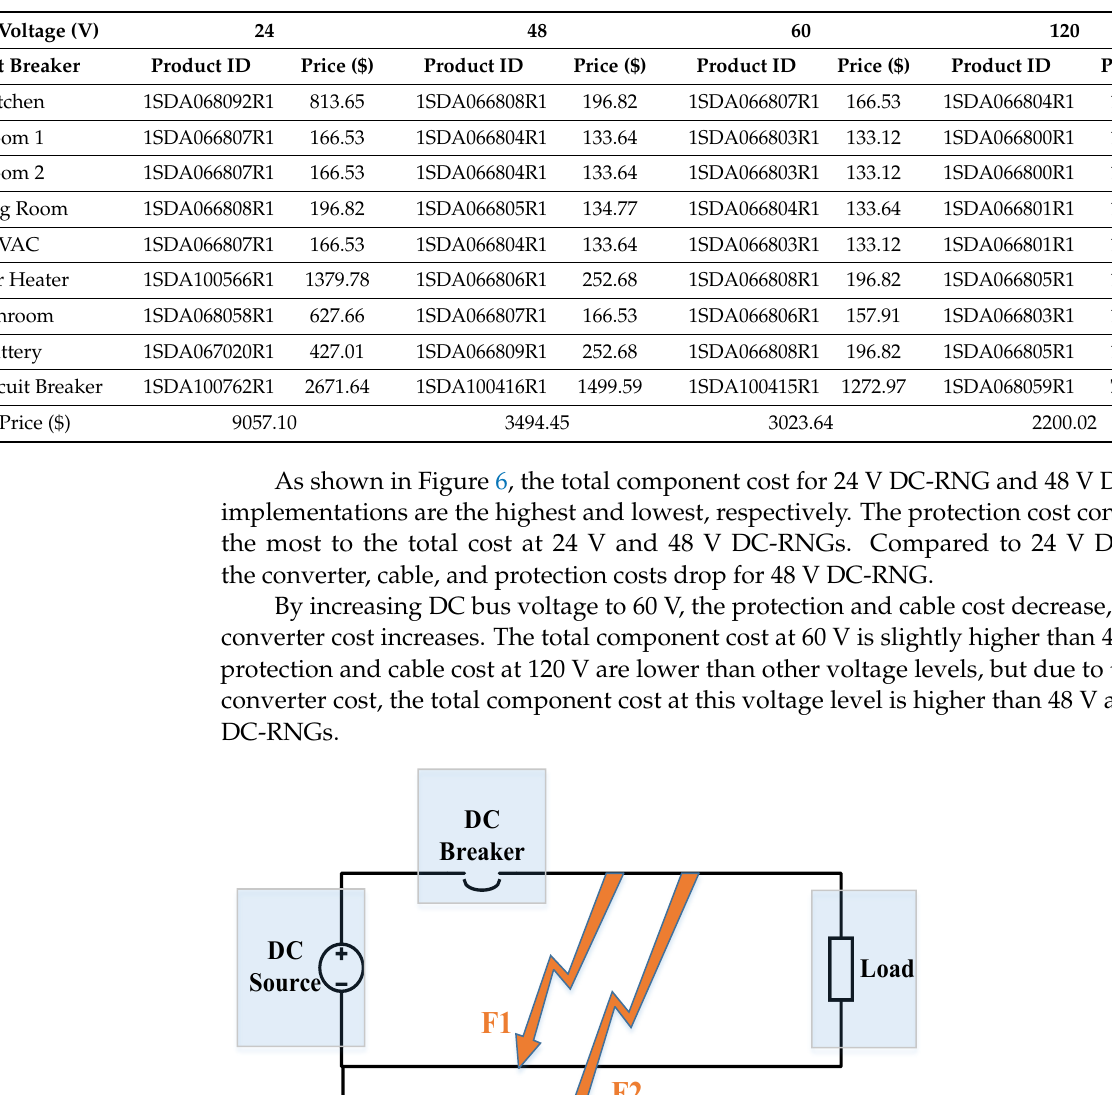
Figure 5. Short circuit faults.